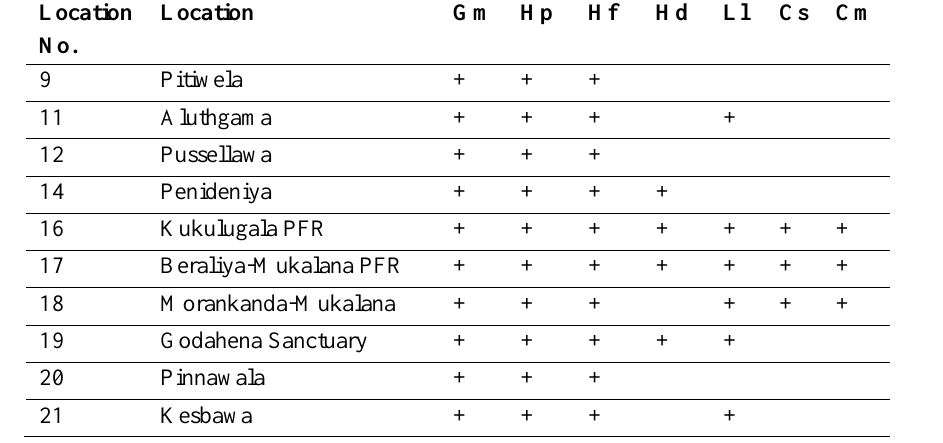
Table 2: Syntopic species of family Gekkonidae recorded on some of Hemiphyllodactylus typus localities (* = endemic species): Gm = Gehyra mutilata ; Hp = Hemidactylus parvimaculatus ; Hf = Hemidactylus frenatus ; Hd = Hemidactylus depressus* ; Ll = Lepidodactylus lugubris ; Cs = Cnemaspis silvula* ; Cm = Cnemaspis molligodai* ; GEt = Geckoella triedrus* ; PFR= Proposed Forest Reserve; += presence (see references in Table